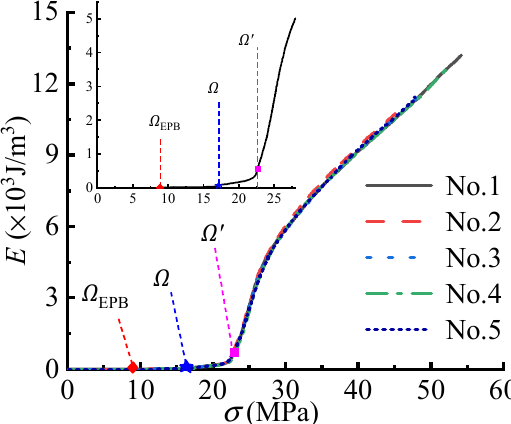
Figure 3. The E − σ curves and the defined essential strengths ( Ω , Ω (cid:48) ). σ − E Figure 3. The curves and the defined essential strengths ( 𝛺 , 𝛺′ ) . Table 1. The 1st essential strength values ( Ω ) of ETFE membrane material under different strain rates. Table 1. The 1st essential strength values ( 𝛺 ) of ETFE membrane material under different strain rates. Strain Strain Rate